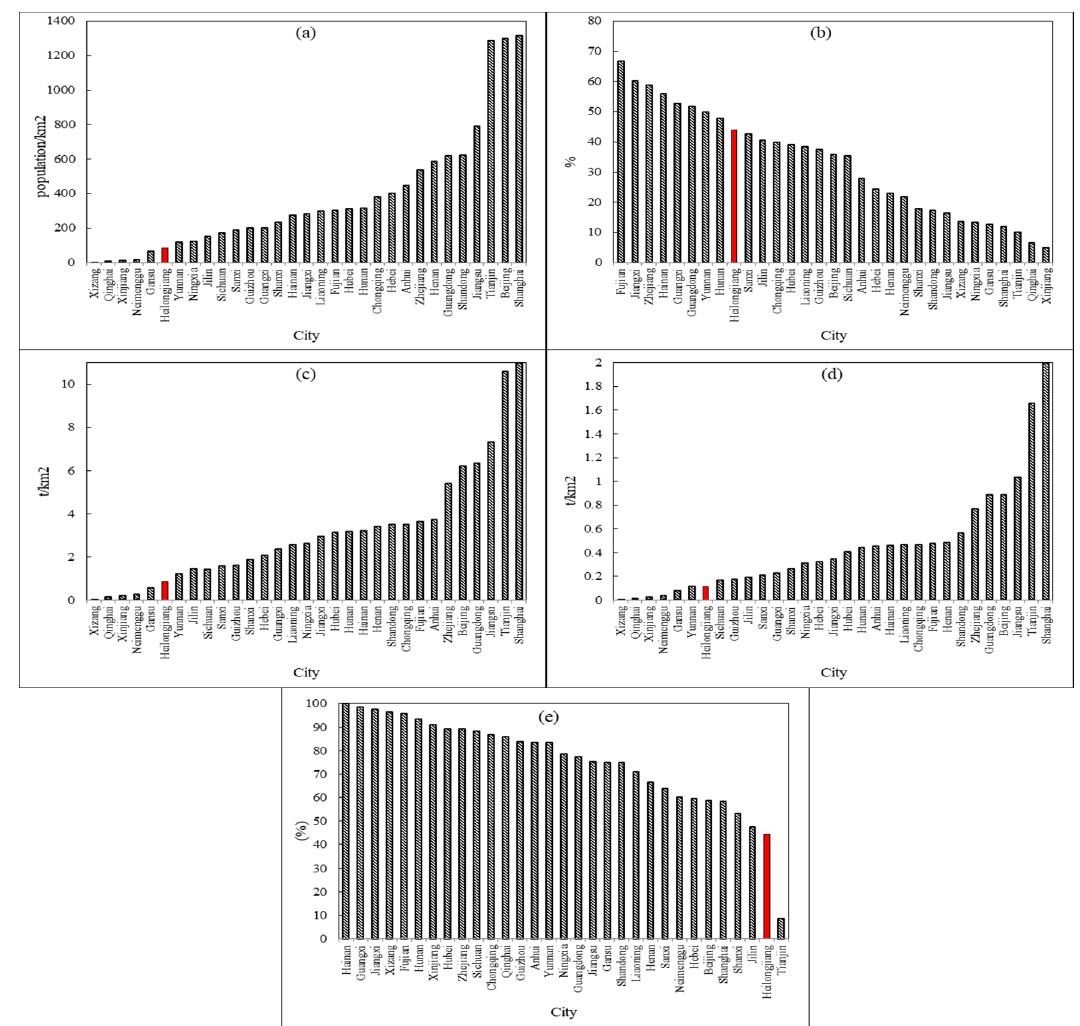
Figure 2. Comparison of factors in 31 provinces of China. ( a ) Population density; ( b ) forest land coverage; ( c ) annual discharge of COD; ( d ) annual discharge of NH 3 -N; ( e ) the rate of water function zones meeting the standard. COD: chemical oxygen demand; NH 3 -N: ammonia nitrogen.